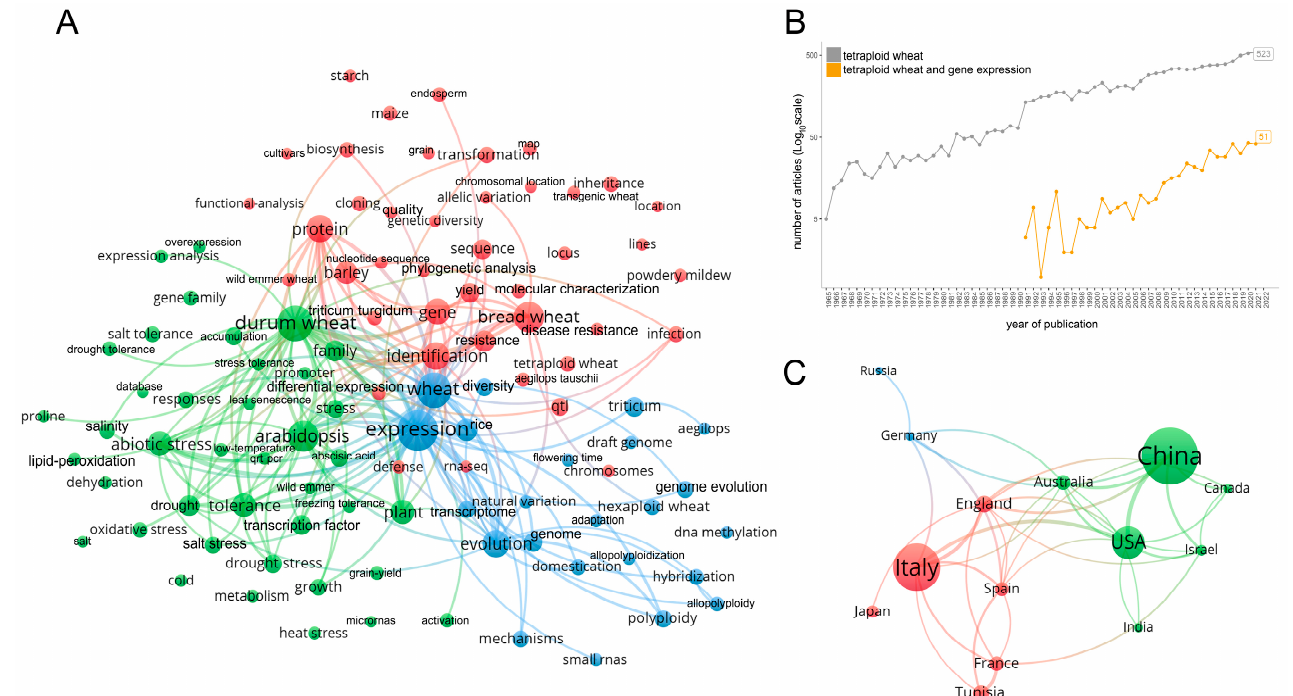
Figure 1. Research topics and their evolution over the years of publications on tetraploid wheat with a focus on gene expression. ( A ) Term map for the 532 retrieved publications focused on gene expression where different colors (red, green, blue) represent the terms (keywords) belonging to different clusters. The size of the nodes (circles) is based on the number of occurrences. Links between nodes indicate the co-occurrence of terms. The connecting lines indicate the 200 strongest occurrence links between terms (minimum strength = 7). ( B ) Number of publications over time on tetraploid wheat subspecies (grey color) and the subset of 532 publications focused on gene expression (orange color). ( C ) Term country map representing country collaborations for the 532 retrieved publications (minimum number of documents per country = 15). The size of the connecting lines indicates the strength of the co-occurrence (minimum strength = 2). Table 1. A summary of transcriptomic studies in durum wheat plants under biotic and abiotic stresses.